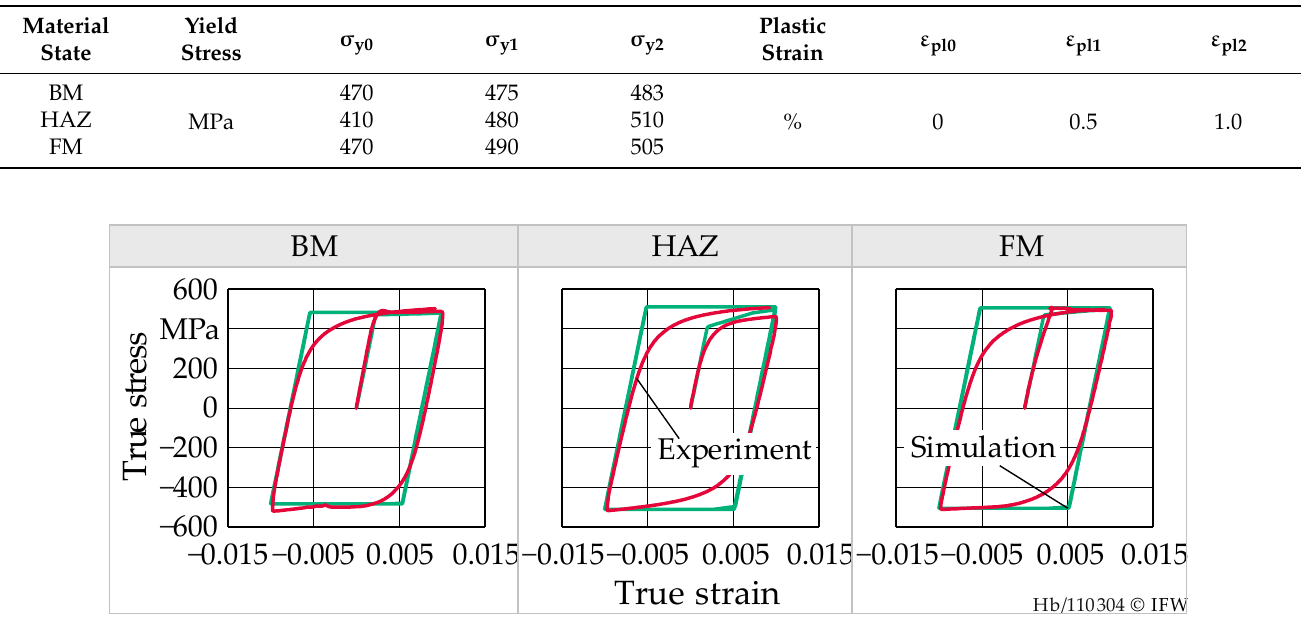
Figure 3. Comparison of stress-strain hysteresis for multilinear isotropic hardening models .